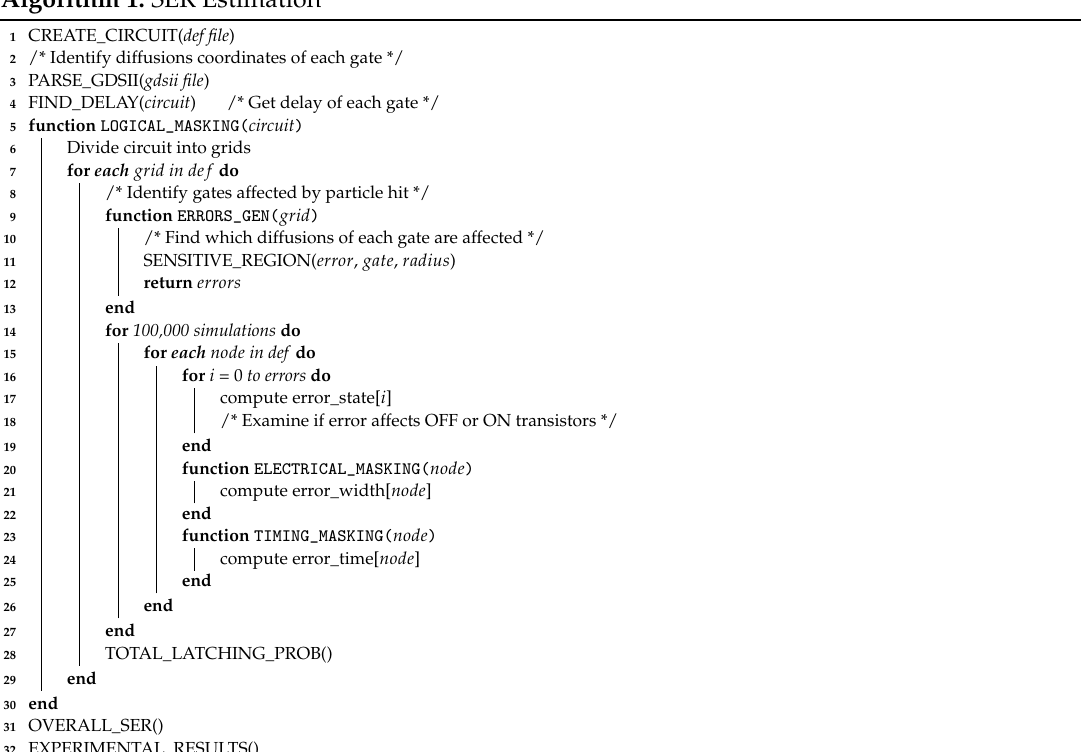
Algorithm 1: SER